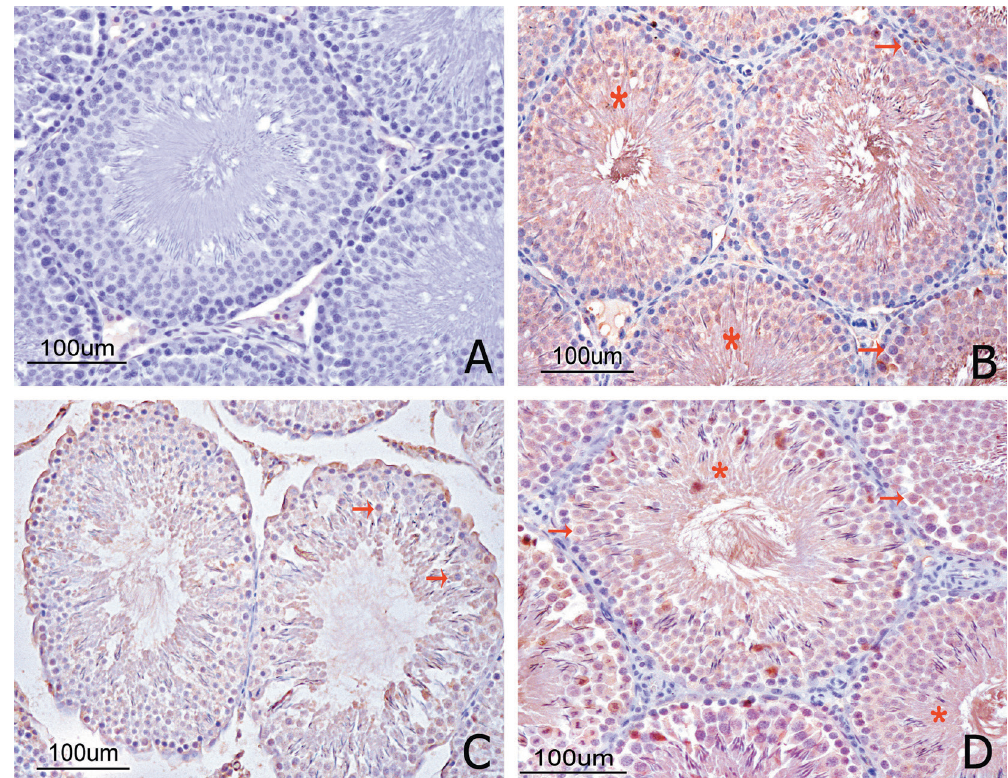
FIGURE 3 - SOD2 immunolocalization in cross-sections of rat testes. (A) The negative control showed no SOD2 staining. (B) The control group showed strong SOD2 expression in the cytoplasm of the germ (arrows) cells and spermatids (stars). No staining was observed in the Sertoli and Leydig cells. (C) The MTX group showed weak cytoplasmic SOD2 immunoreactivity in the germ cells (arrows). (D) The MTX + SMN group showed stronger cytoplasmic SOD2 immunoreactivity in the germ cells (arrows) and spermatids (stars) than the MTX group